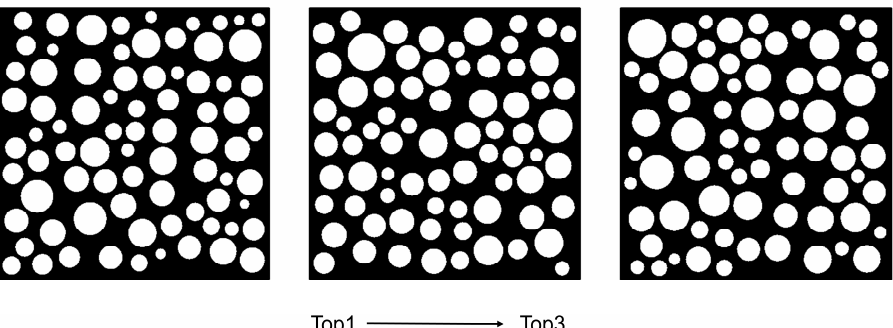
Figure 12. Structure diagram of the top three elastic moduli in the database.